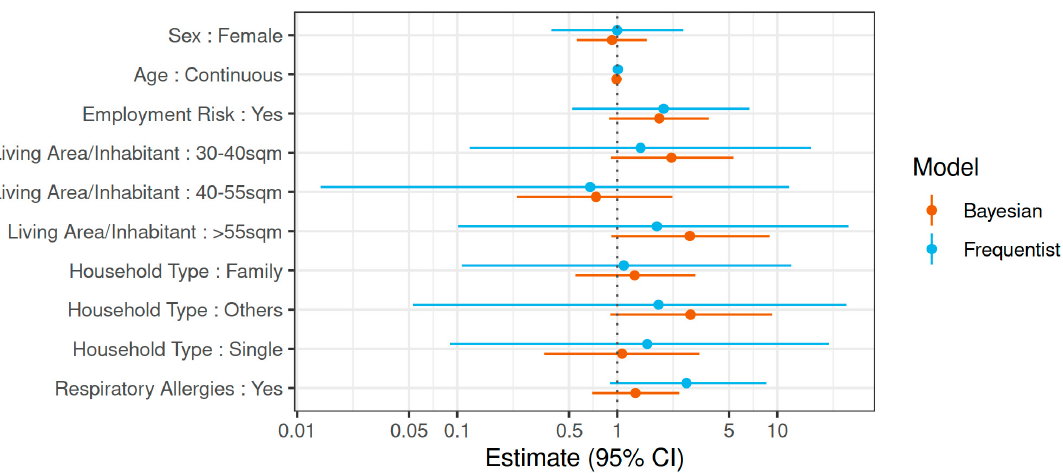
Figure 5. Multivariate risk factor analysis for SARS ¬ CoV-2 seropositivity. Multivariate risk factor analysis for SARS-CoV-2 seropositivity mutually adjusted for all variables in the figure. OR: odds ratio; 95% CI: 95% credible interval (Bayesian analyses)/95% confidence interval (frequentist GLMM).